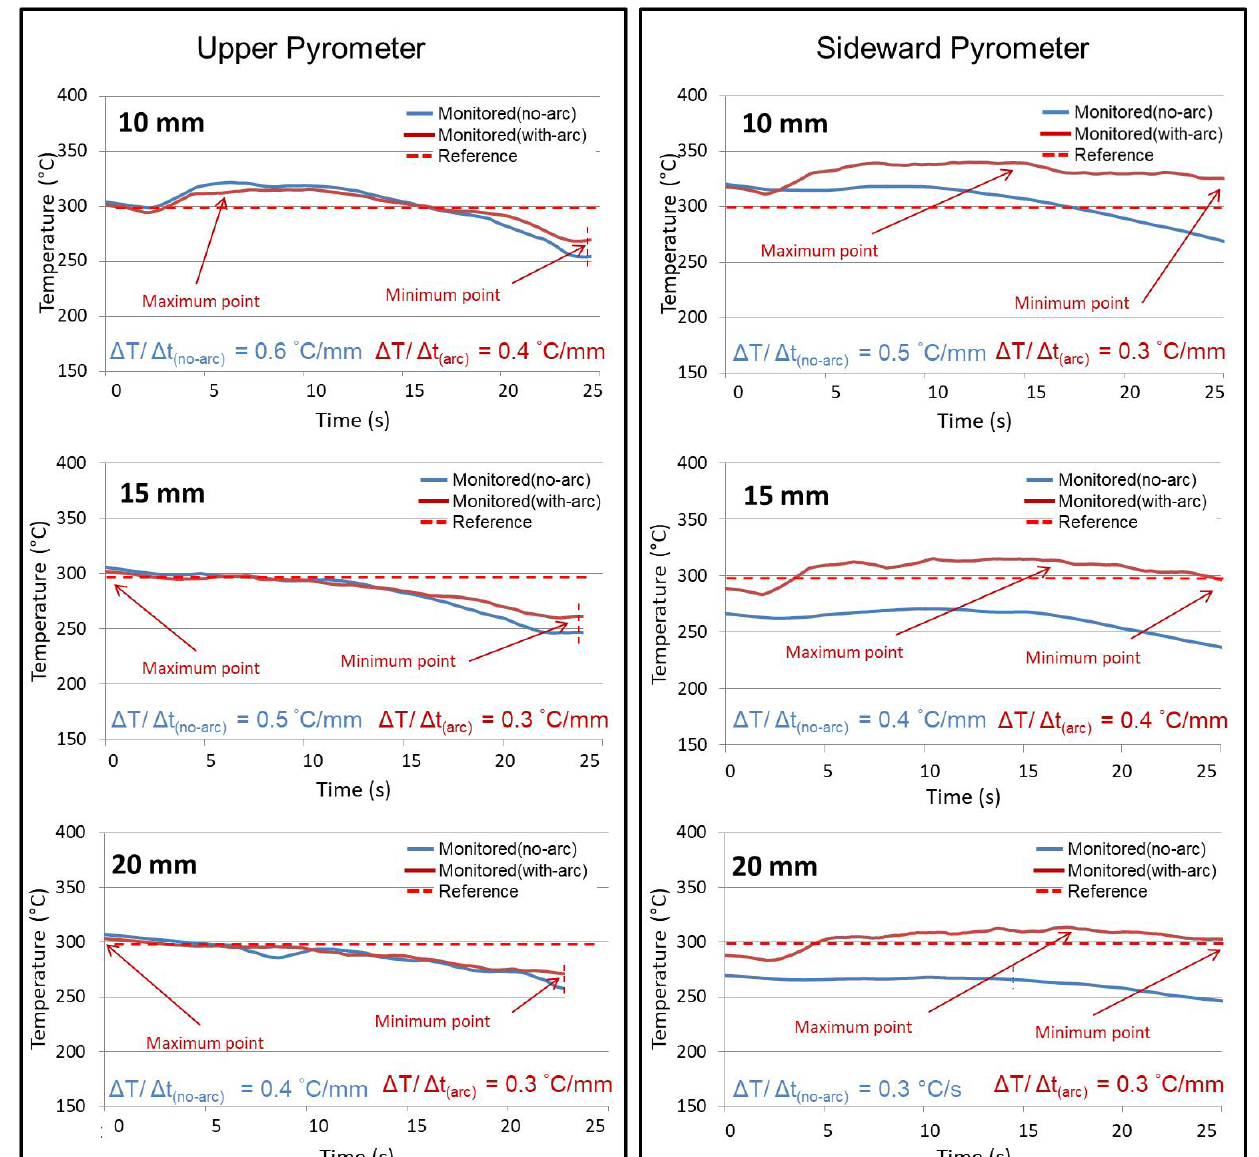
Figure 12. Typical temperature profiles resultant from the two pyrometer approaches with the torch movement with/without arc, for different measurement distances “L”, where ∆ T/ ∆ l is the temperature gradient per unit of layer between the maximum and the minimum temperatures points.